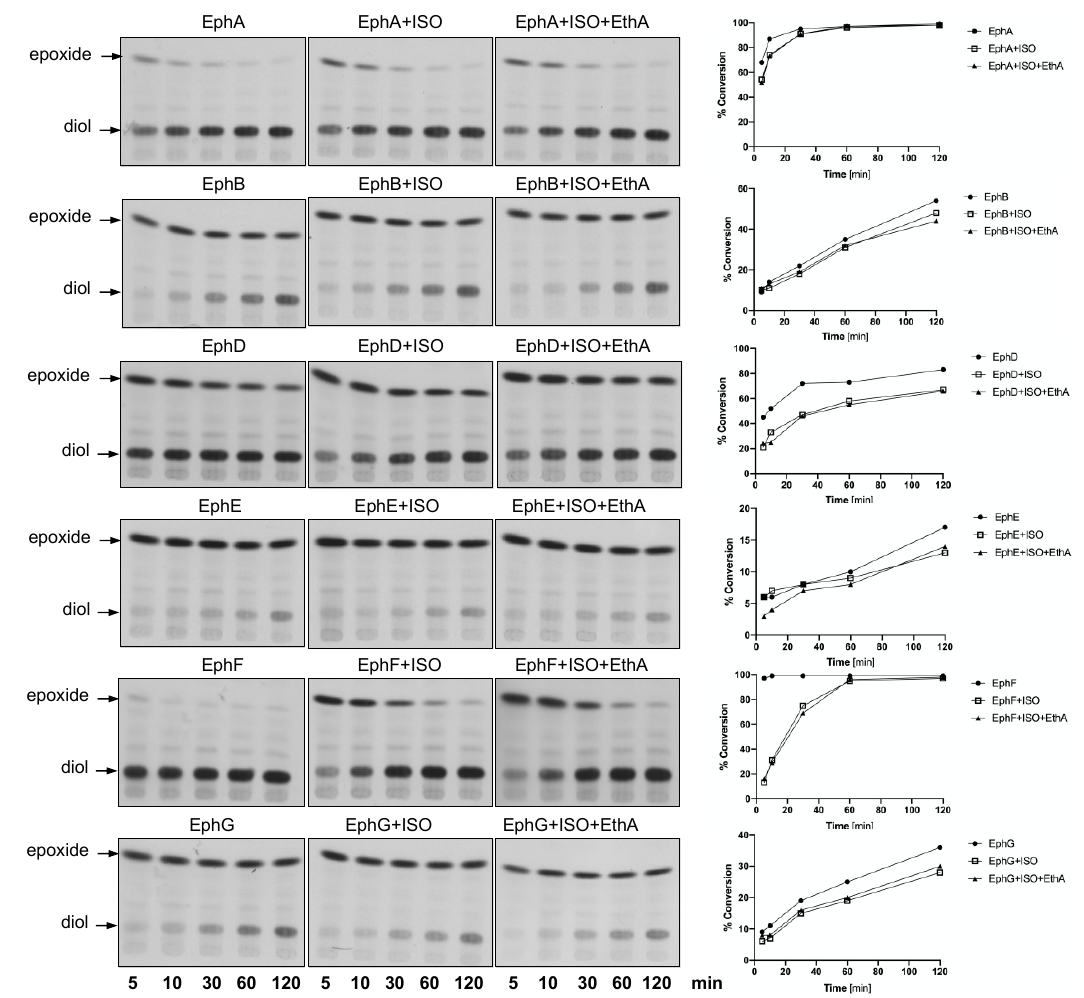
Figure 2. Epoxide hydrolase activity of EphA, EphB, EphD, EphE, EphF and EphG proteins in vitro in the presence of 10 µ g/mL of ISO. Left: Thin-layer chromatography of in vitro reactions with 10,000 × g supernatants of lysates of E. coli strains producing EHs from M. tuberculosis using [ 14 C]-9,10- cis -epoxystearic acid as the substrate. Reactions ran for 5, 10, 30, 60 or 120 min at 37 °C. Plates were developed in n -hexane:diethyl ether:formic acid (70:30:2) and visualized by autoradiography. Right: Quantification of results of thin-layer chromatography (TLC) analysis. For each condition, the EH activity was expressed as percentage of substrate conversion.